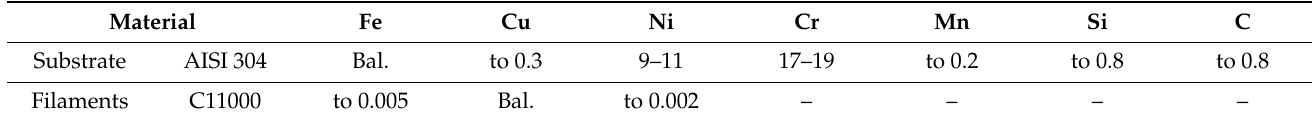
Table 1. Chemical composition of the substrate and filaments used in wire-feed electron beam additive manufacturing (wt. %).